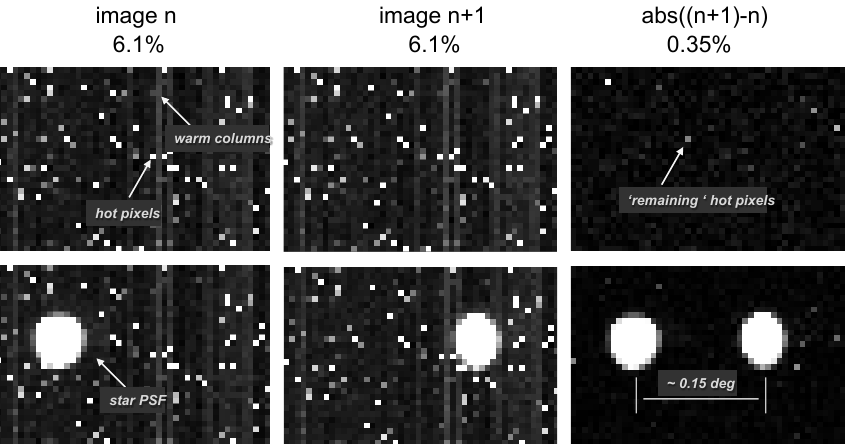
Figure 7. Illustration of the chopping procedure. Top: empty rasters (24 × 36 pixel subsets of a frame). The left and middle raster was off-set horizontally by about 0.15 ◦ . Bottom: same as for top row, but with the telescope moved to a nearby star in the raster. Right column: absolute values of the raster differences. All images here were taken at about +20 ◦ C operating temperature. The values on top of the upper row are the % of pixels which reveal a dark current higher than 100ADU, compared to the median background of all pixels in the respective